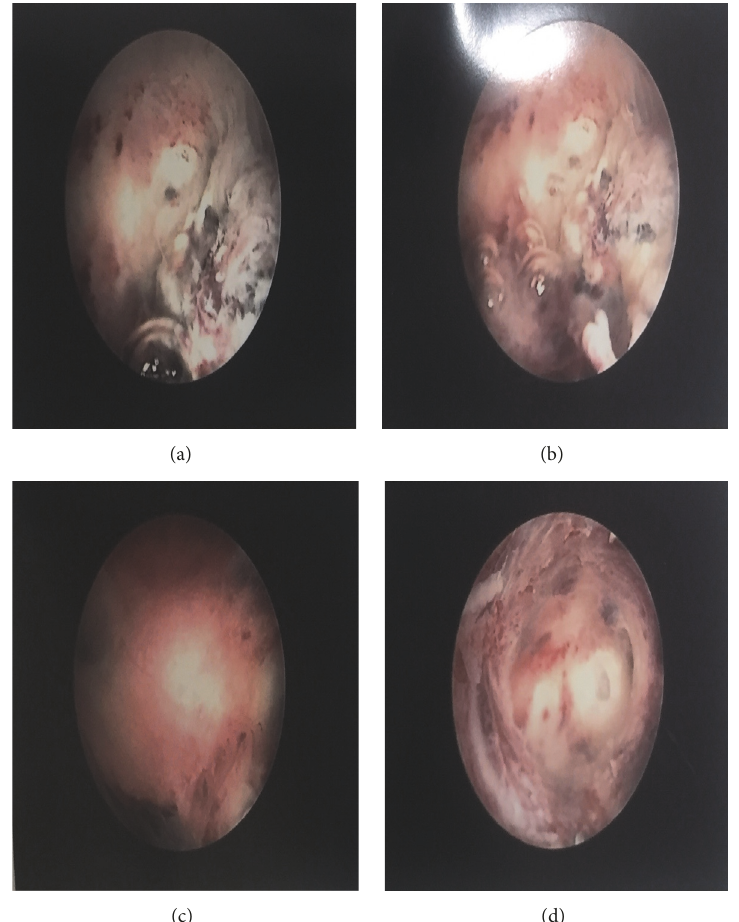
Figure 1: Retained products of conception: (a) and (b): prehysteroscopic morcellation and (c) and (d): postmorcellation appearance with the Intrauterine Bigatti Shaver